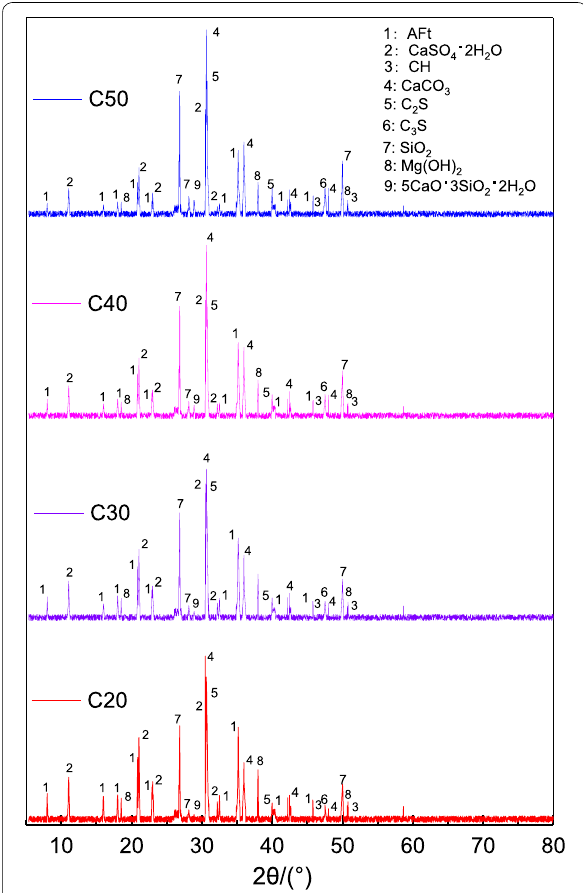
Fig. 9 XRD patterns of different strengths of concrete in corrosive solution. Fig. 10 Relative dynamic elastic modulus under freeze–thaw